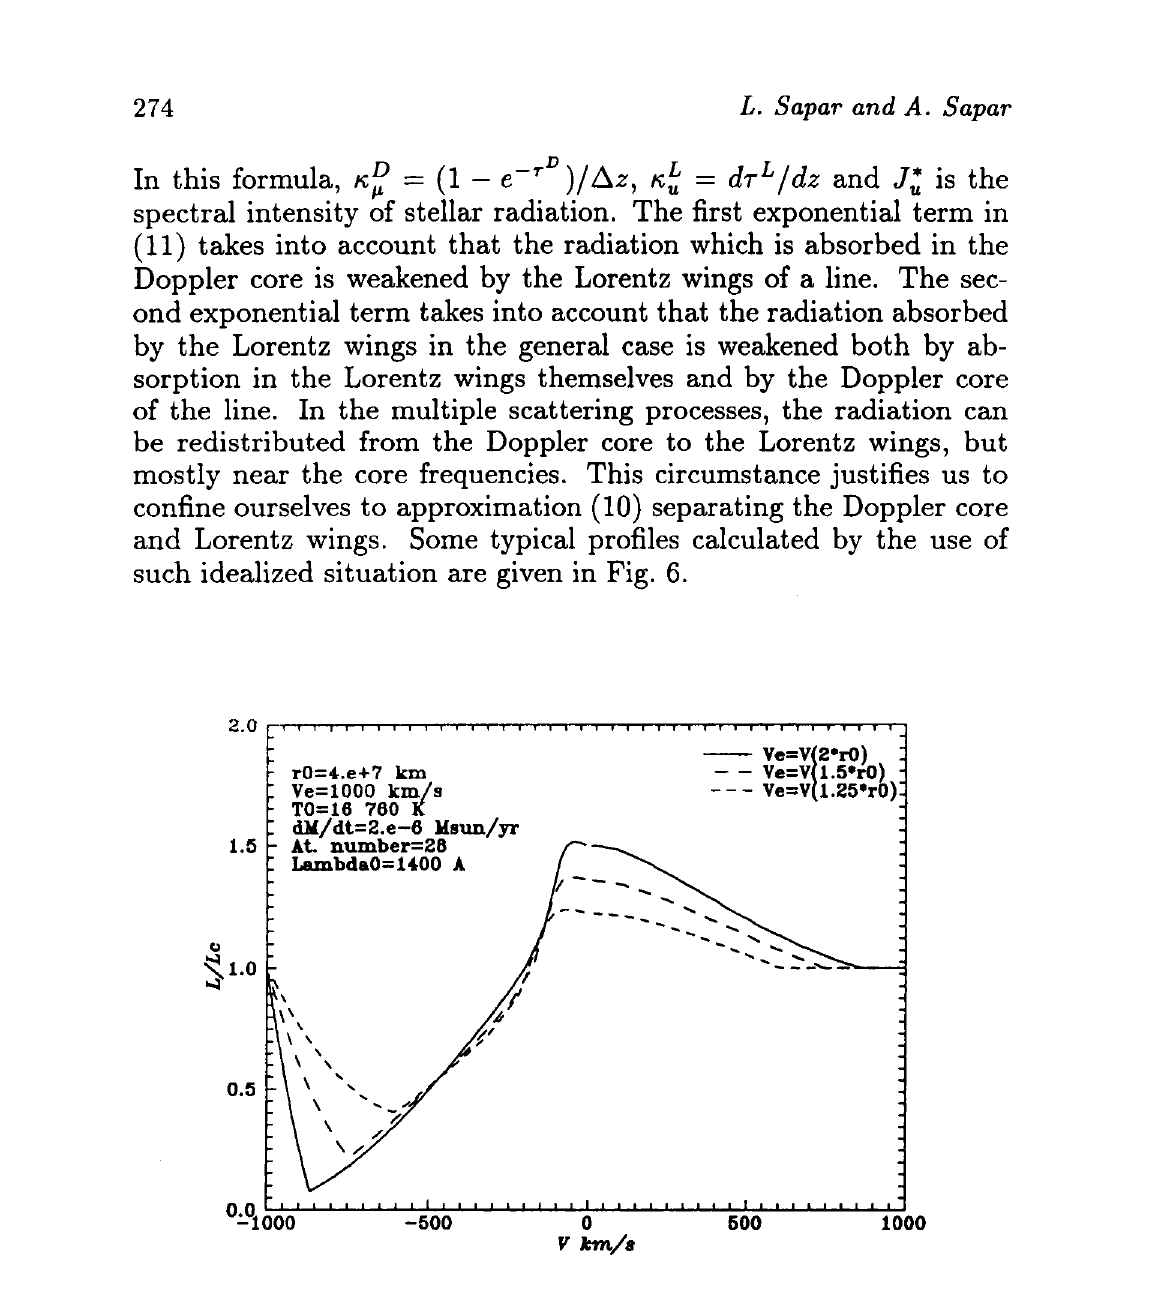
Fig. 6. Standard spectral line profile computed for SilV resonance line in the simplified case with lacking atmospheric line and accelerating wind. As extreme velocity -1000 km/s has been taken and the line profile for three cases of different extension of stellar wind have been